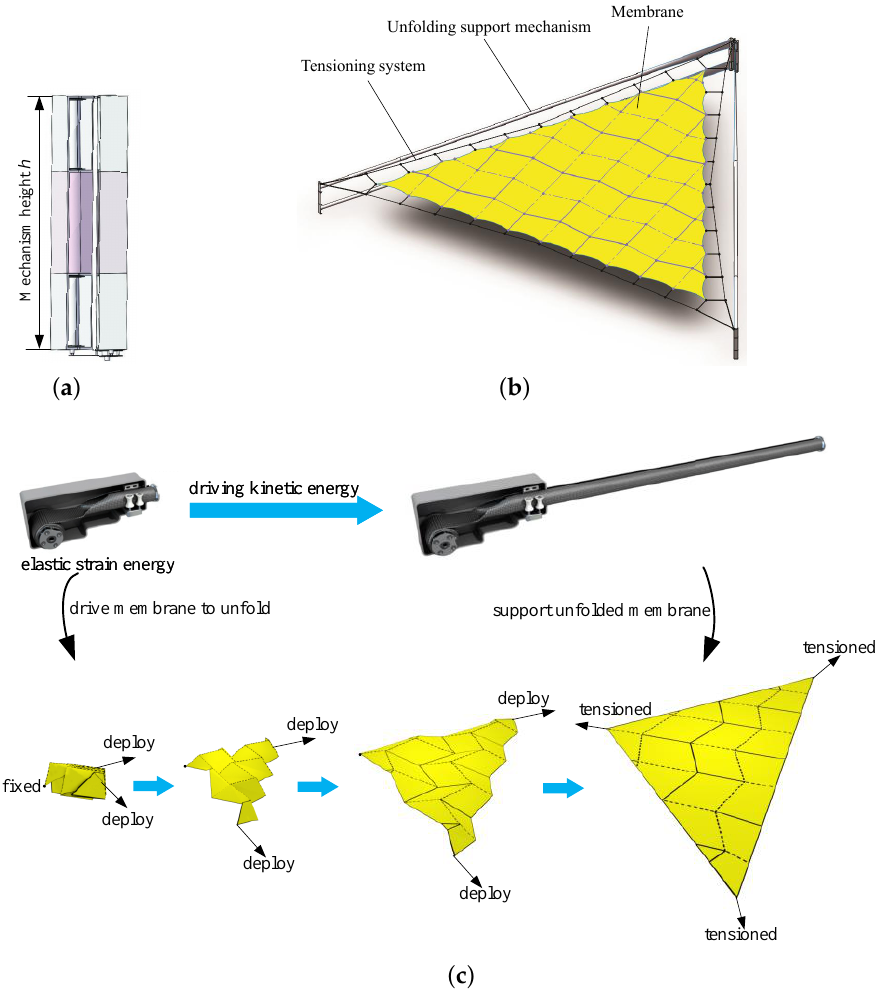
Figure 1. ( a ) Folded state of the triangular space membrane deployable mechanism. ( b ) Unfolded state of the triangular space membrane deployable mechanism. ( c ) Schematic of the mechanism in action during deployment of the